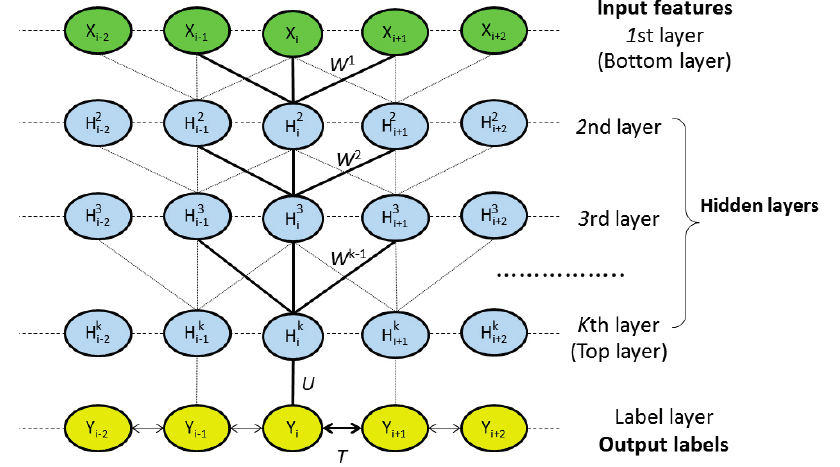
the associated (cid:3036)